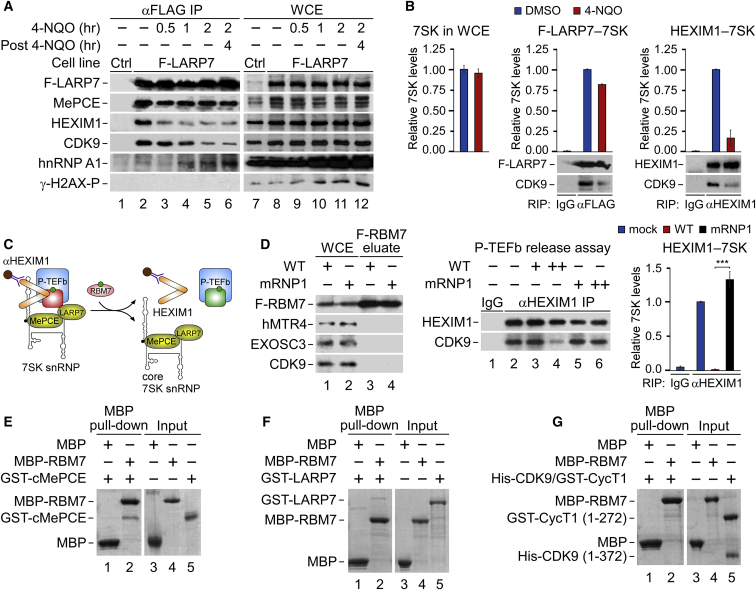
RBM7 Releases P-TEFb from the Core of 7SK snRNP upon Genotoxic Stress(A) CoIP of F-LARP7 with 7SK snRNP and γ-H2AX from WCE of HEK293 cells. Conditions with (in hours) and without (−) 4-NQO are shown.(B) RT-qPCR of 7SK (left) and RIP-qPCR of 7SK in F-LARP7 (middle) and HEXIM1 (right) IP from WCE of HEK293 cells. Conditions with (red bars) and without (blue bars) 4-NQO are shown. Results are presented as the mean ± SEM (n = 2). Protein levels in the IP are shown below the graphs.(C) Cartoon depicting P-TEFb release assay. Release of inactive P-TEFb (CDK9 in red) from 7SK snRNP abrogates the P-TEFb–HEXIM1 interaction, resulting in P-TEFb activation (CDK9 in green).(D) Left: eluates of immunopurified wild-type and mRNP1 F-RBM7 from HEK293 WCE. Middle: western blot analysis of P-TEFb release from HEXIM1 immunopurified (αHEXIM1 IP) 7SK snRNP by the F-RBM7 proteins. Control (−, lanes 1 and 2) and conditions with (+) increasing amounts of wild-type and mRNP1 F-RBM7 are shown. Right: RIP-qPCR of 7SK in HEXIM1 IP. Conditions with wild-type (red bars), mRNP1 (black bars), and without (blue bars) F-RBM7 incubation are shown. Results are presented as the mean ± SEM (n = 4). ∗∗∗p < 0.001, determined by Student’s t test.(E–G) Coomassie-stained gels of in vitro MBP pull-down assays of MBP-RBM7 with GST-cMePCE (E), GST-LARP7 (F), and His-CDK9/GST-CycT1 (G).See also Figure S3.